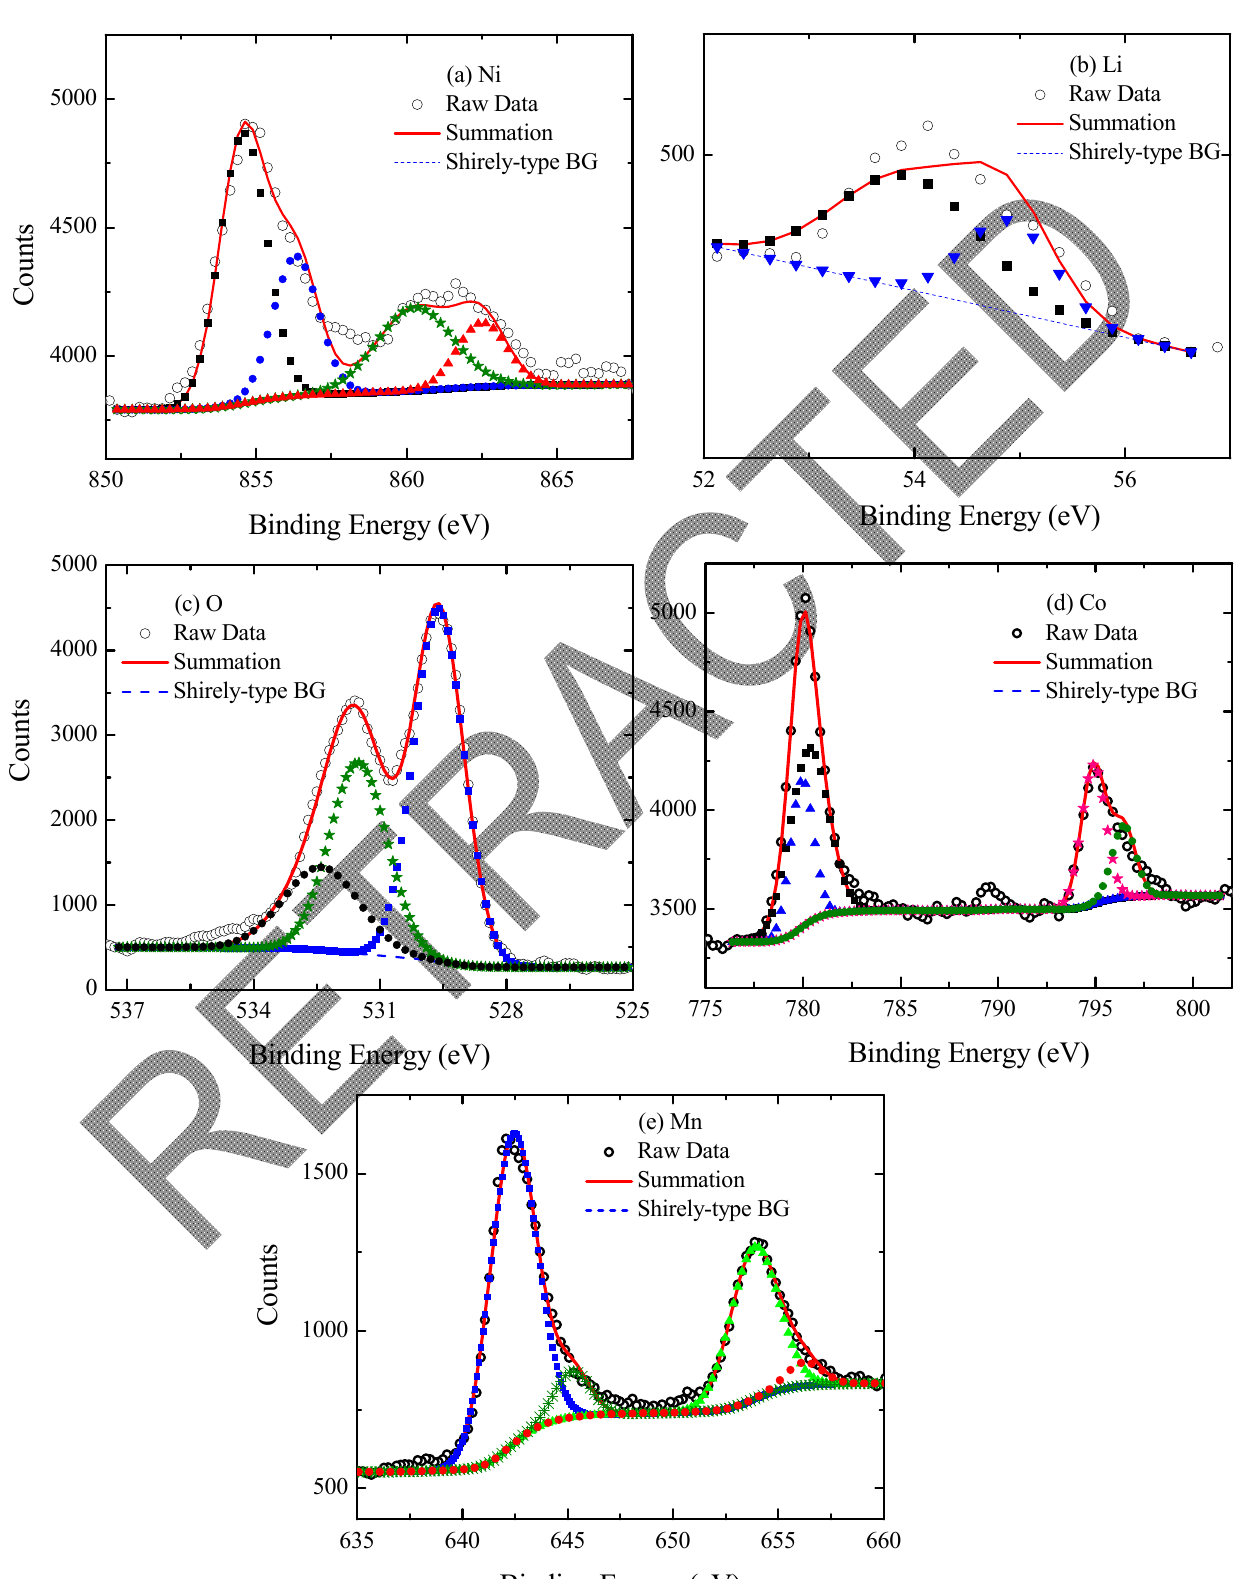
Figure 7. XPS spectra of all the compositions showing the electronic transitions of elements present. Measured and fitted transition-metal spectra of the # 6. ((cid:31)) represents the measured data points, (closed symbols) individual curve, (- -) Shirley background, and (-) summation curve. Peak assignments are discussed in the